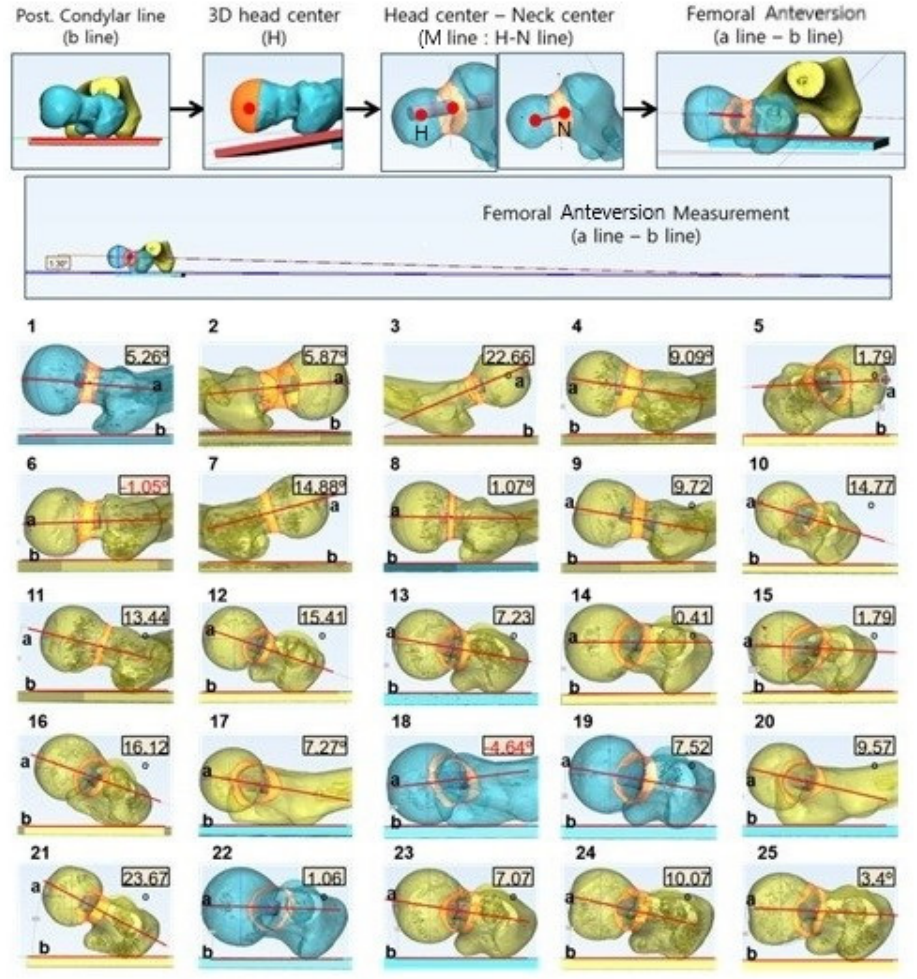
Figure 10. Femoral anteversion angle using the M line in 3D volumetric reconstruction was obtained from cranial to caudal in the 3D view of volumetric reconstruction. Mimics ® Innovation Suite (Materialise, Leuven, Belgium) software was used for creating 25 cadaveric femur 3D model and volumetric femoral anteversion measurements.